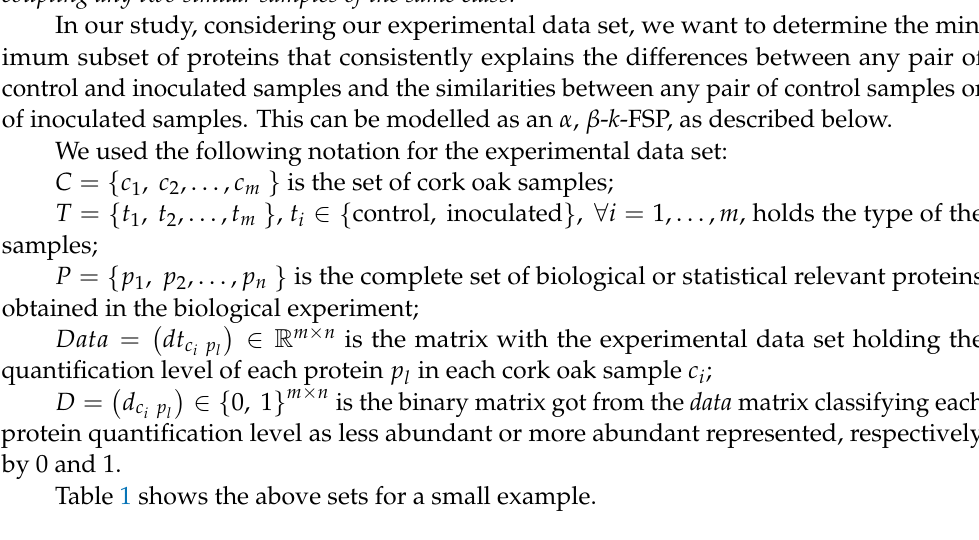
Table 1. Data for a small